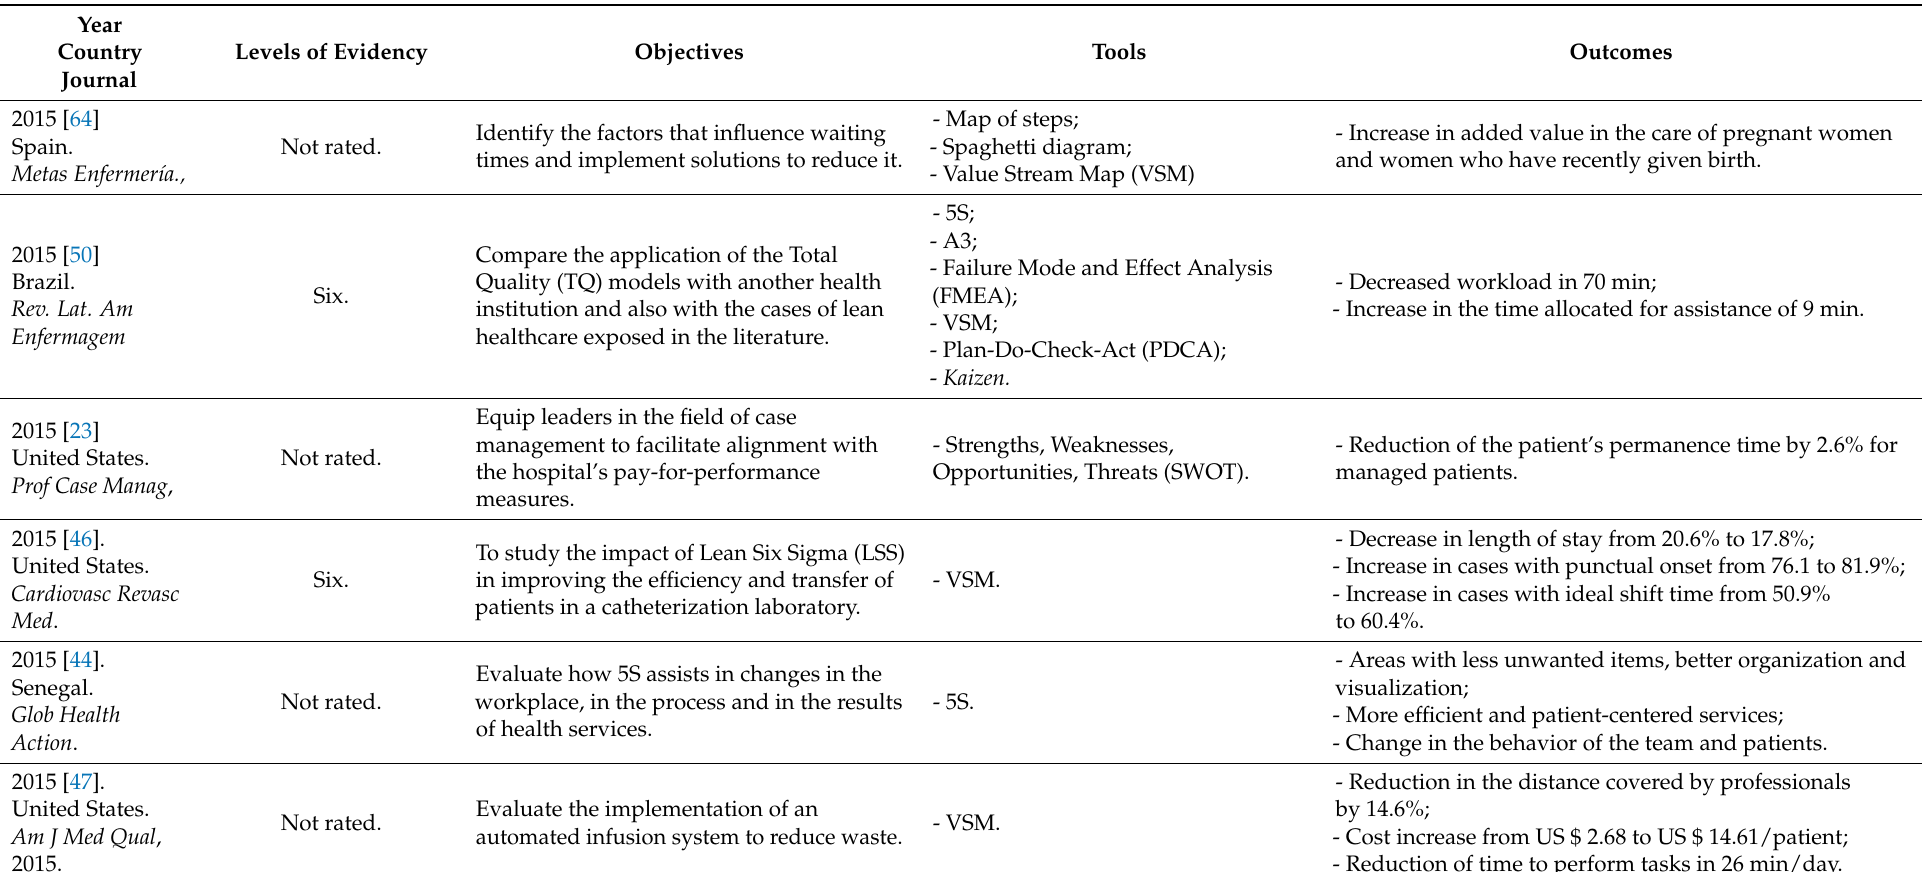
Table A1. Characteristics of publications on the use of Lean tools in order of year of